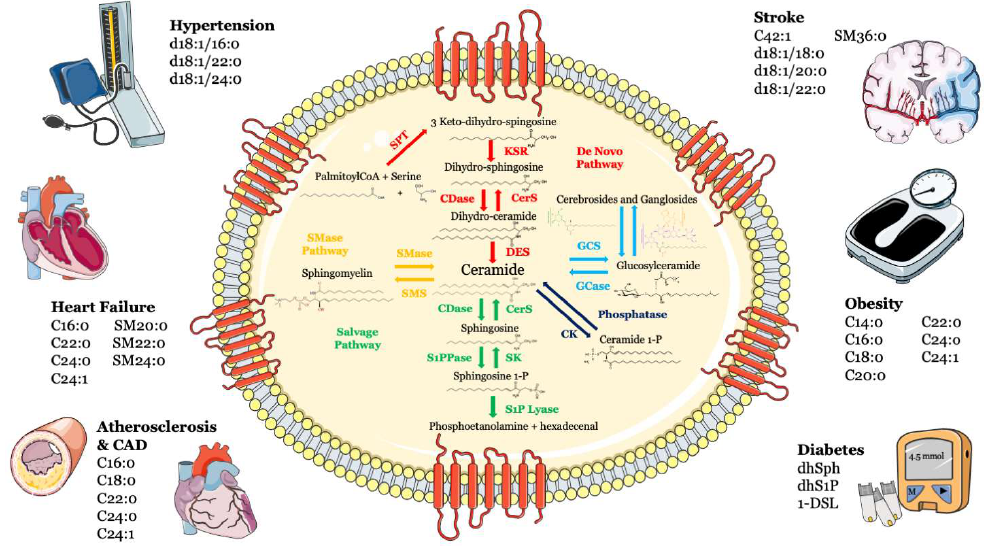
Figure 1. Metabolism and structure of sphingolipids and their implication in cardio- and cerebrovascular diseases. Sphingolipid metabolism and structure are illustrated inside the cell. Ceramide is the heart of the sphingolipid metabolic pathway. Ceramide can be synthesized through several steps: (i) de novo synthesis pathway starting from l-serine and palmitoyl-CoA (red); (ii) SMase pathway, through hydrolysis of sphingomyelin (yellow); (iii) salvage pathway, long-chain sphingoid bases are reused to form ceramide through the action of ceramide synthase (green); (iv) or through hydrolysis of glycosphingolipids and sulfatites (azure). Ceramide can also be synthesized from ceramide-1-phosphate through the action of ceramide-1-phosphate phosphatase (blue). The main cardiovascular diseases and risk factors in which sphingolipids may be used as biomarkers are summarized outside the cell. Abbreviations: serine palmitoyl-CoA-acyltransferase (SPT), 3-ketosphinganine reductase (KSR), (dihydro)-ceramide synthase (CerS), ceramide desaturase (DES), ceramide kinase (CK), glucosylceramide synthase (GCS), glucosyl ceramidase (GCase), ceramidase (CDase), sphingosine-1-phosphate lyase (S1P lyase), sphingosine kinase (SK), sphingosine 1-phosphate phosphatase (S1PPase), sphingomyelin (SM) synthase (SMS), sphingomyelinase (SMase).